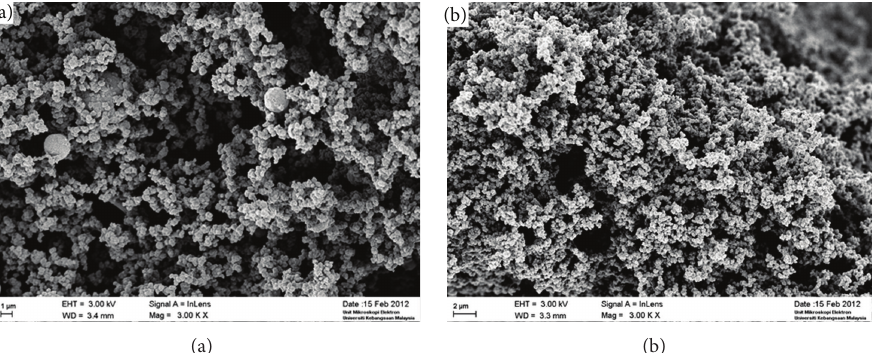
Figure 7: FESEM images of (a) pure Ppy and (b) WO 3 -Ppy nanocomposite.